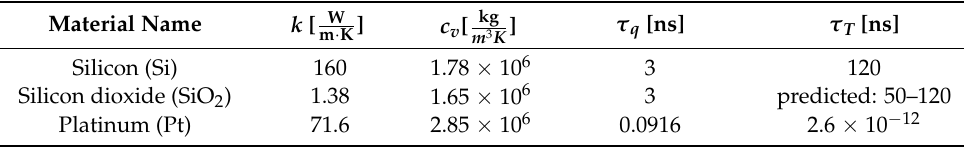
Table 1. Considered material parameter values based on [1,30].